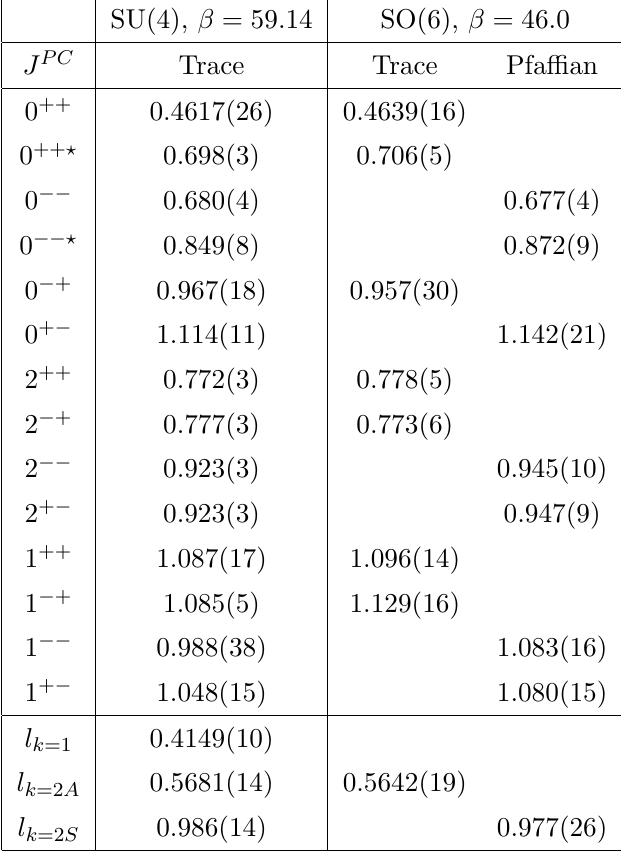
Table 5 . Lightest glueball masses in SU(4) and SO(6) on a 36 2 44 lattice at the couplings shown for various spins J and parity P . For SU(4) labelled by charge conjugation C , and for SO(6) in the two sectors indicated, as explained in text. Also shown is the energy of the lightest k -string, l k , winding around a periodic spatial direction.